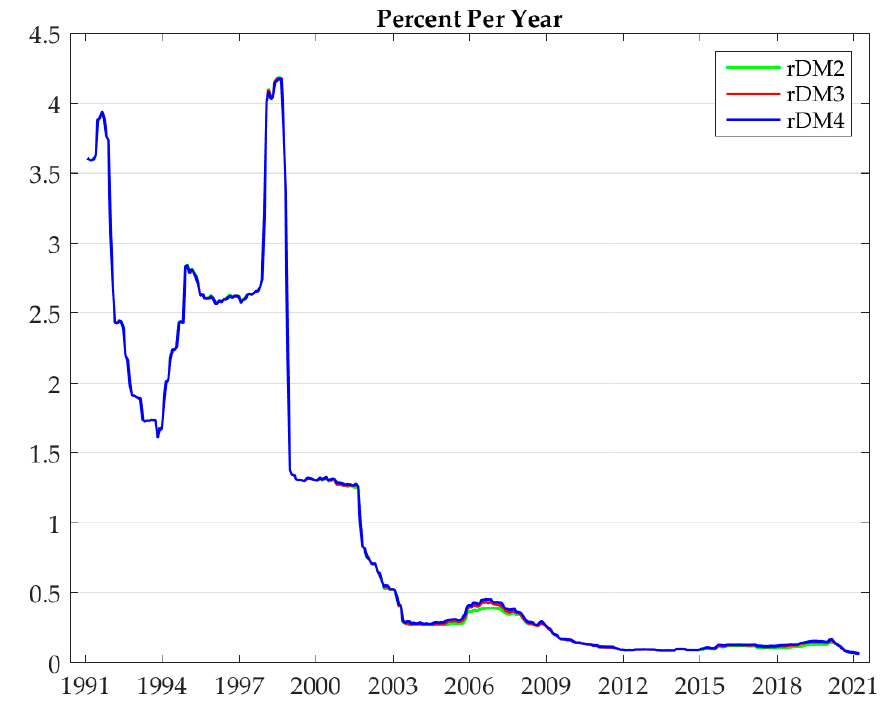
Figure 5. Interest rate aggregates 1991–2021.